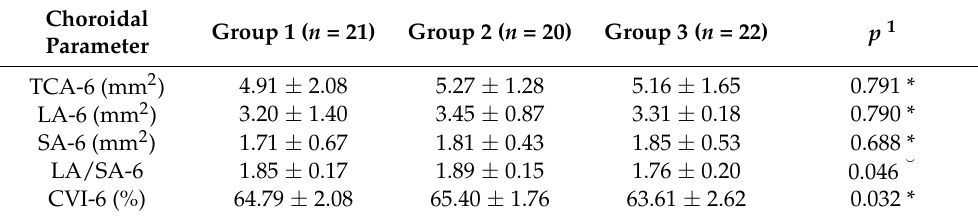
Table 6. Choroidal parameters in the studied groups for the choroidal area under the 6 mm horizontal line centered on the